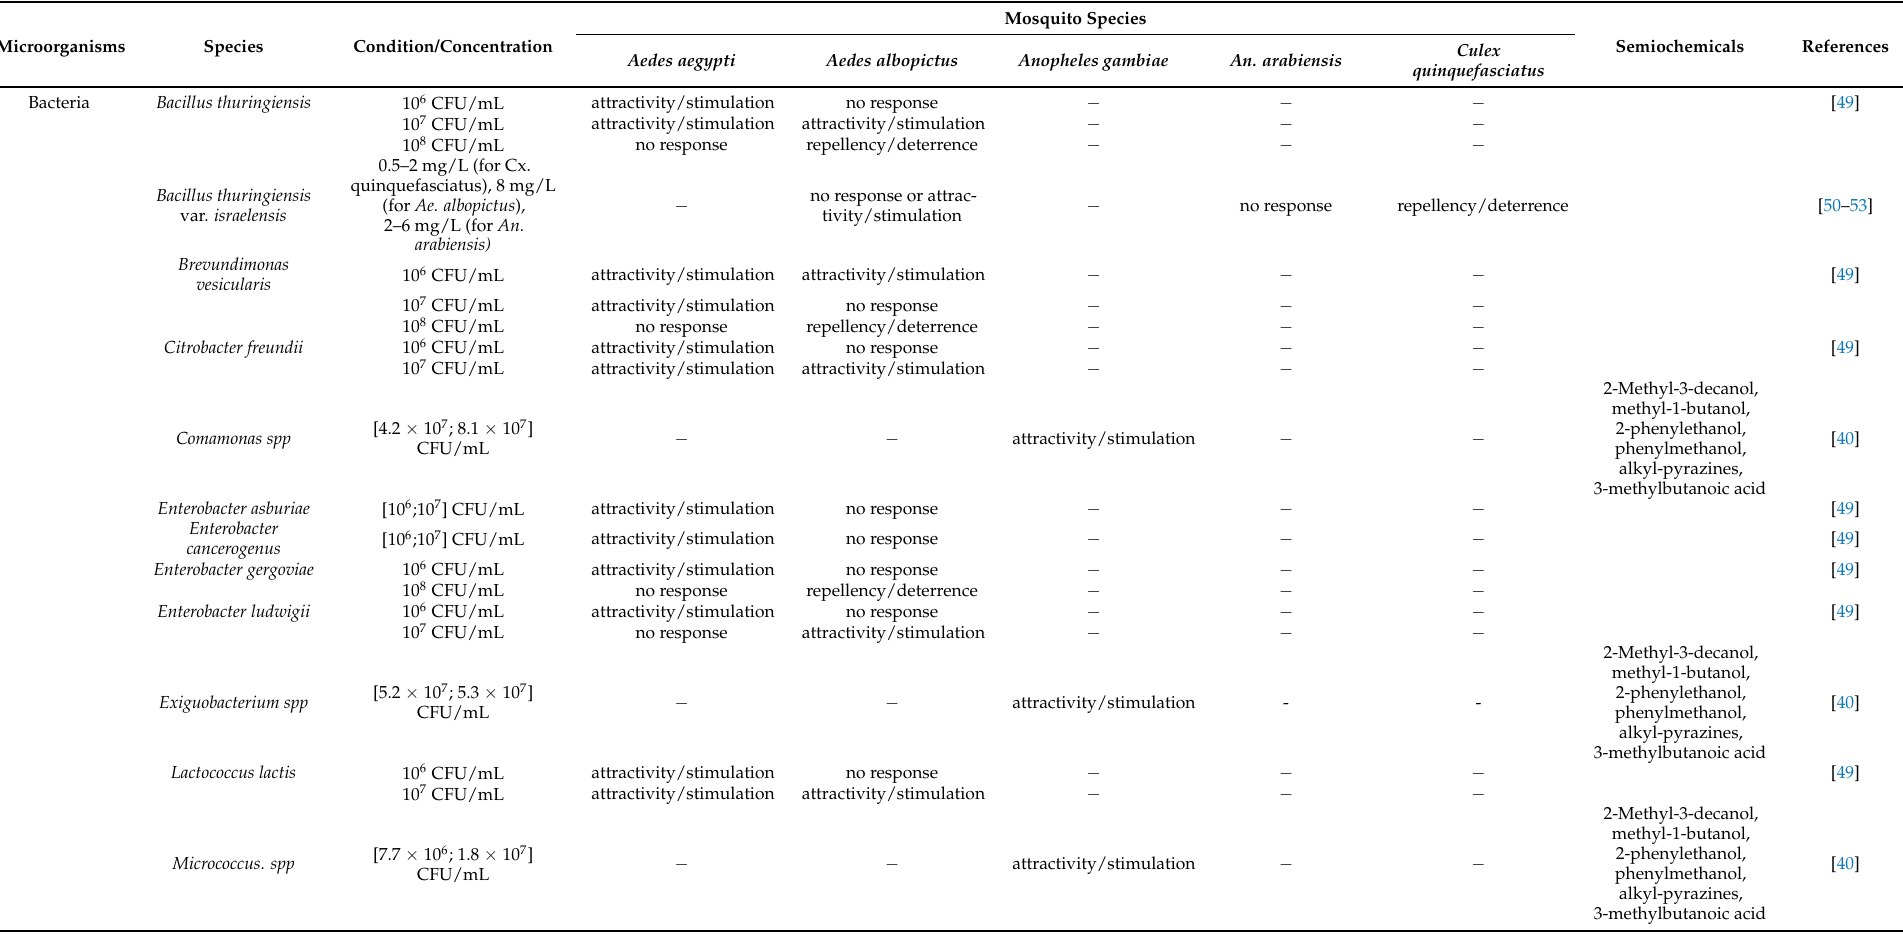
Table 1. Microoganisms that influence the oviposition strategy of Aedes aegypti, Ae. albopictus , and Anopheles gambiae